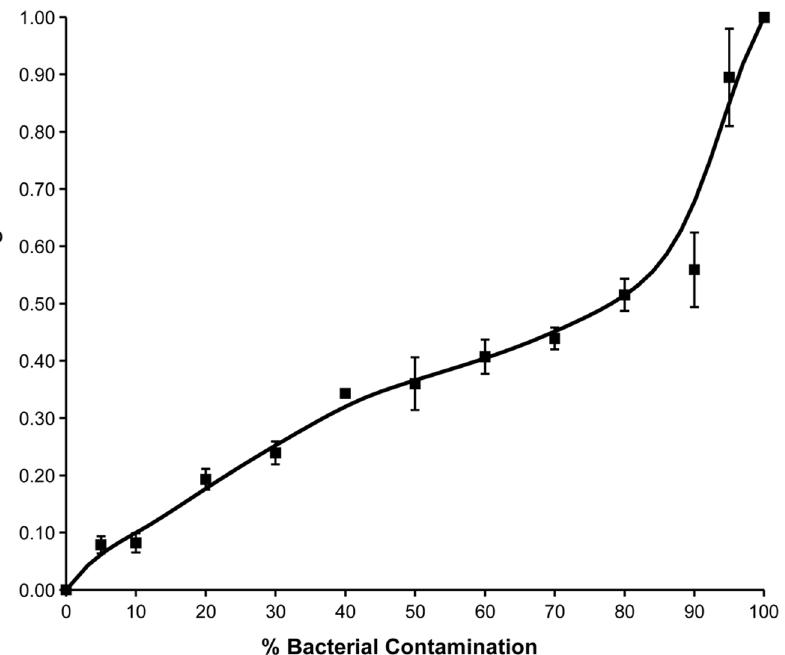
Figure 4. Assay Standard Curve for use in Quantification of Bacterial Contamination of Loricate Choanoflagellate Cultures. The relative 16S band brightness is here plotted against percentage of bacterial 16S target sequence in the template DNA. The error bars at each point show 6 standard error. This graph can be used as a standard curve to determine the relative levels of bacterial contamination in DNA samples. It may also be used in conjunction with absolute readings of DNA concentration to provide the basis for absolute quantification of the bacterial and choanoflagellate content in the original nucleic acid sample. doi:10.1371/journal.pone.0061732.g004 band brightness and template concentration means that, at a given template amount, independent assay results are comparable.